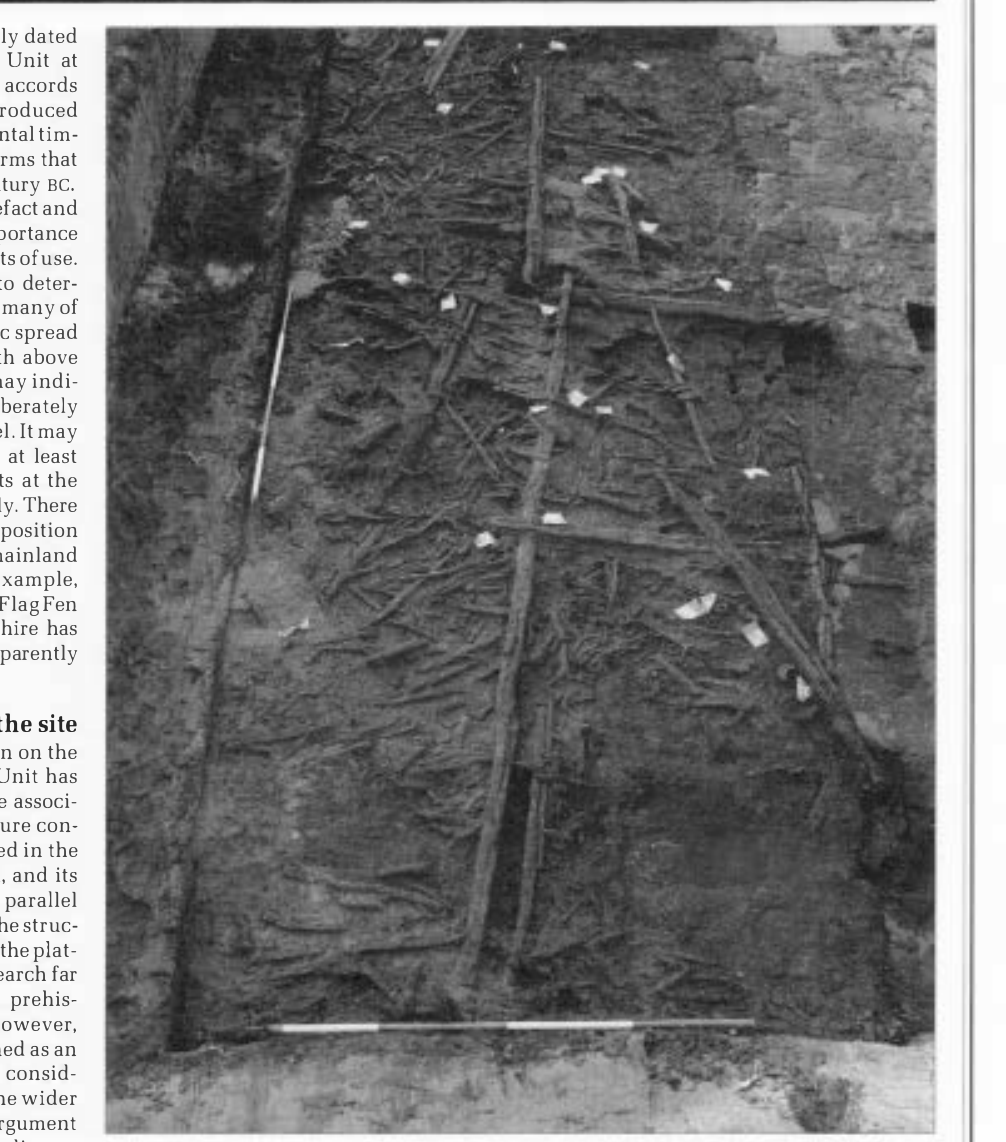
Figure 2 Part of the 60m length of waterlogged Bronze Age trackway excavated at Wil­ lingdon Levels, dated to the ninth century BC (scale bar intervals 50